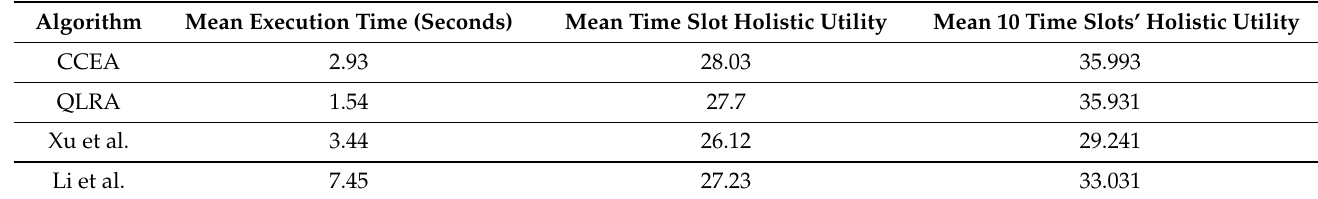
Table 4. Computational complexity and mean holistic utility over time slot